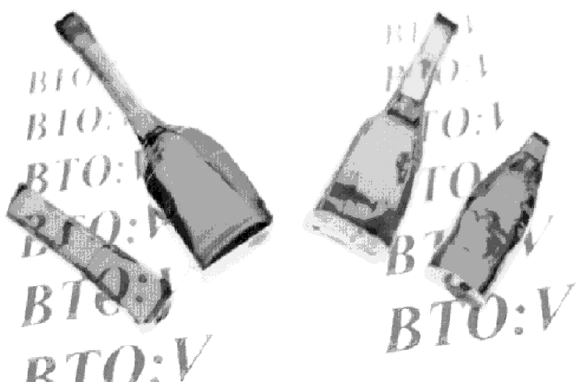
Figure 1. Some as-grown BTO:V crystals. The first two crystals in the left side were grown from composition x = 0.10 in the melt, and the others from x = 0.15. Structural defects can be seen in the two crystals at right